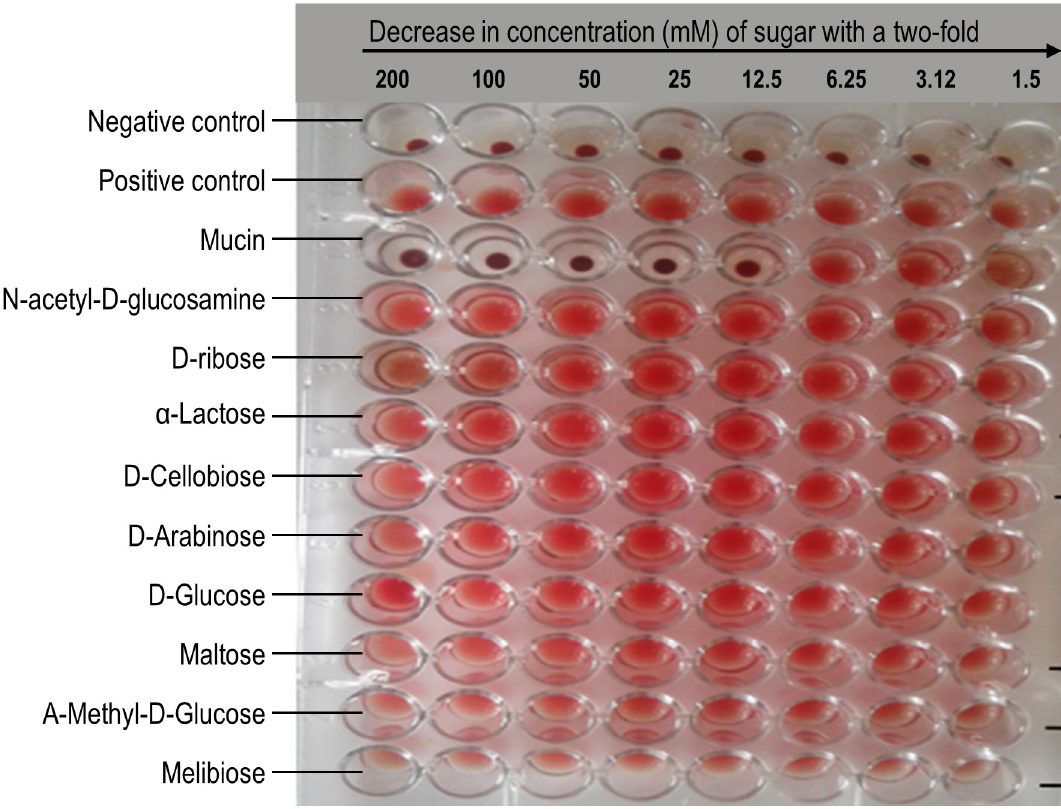
Fig 1. Boletus edulis lectin haemagglutination inhibition assay by various sugars and sugar derivatives using sheep erythrocytes. The sugars had their concentration of 0.2 M serially diluted with 0.9% saline solution from the first well to the last well of the row. Porcine mucin inhibited haemagglutination activity of crude B . edulis lectin up to 12.5 mM.